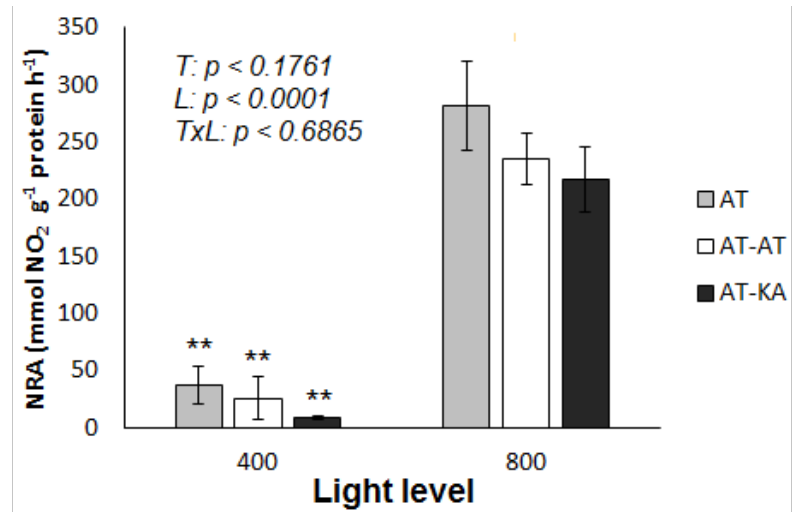
Figure 4. Nitrate Reductase Activity (NRA) in leaves from plants exposed to medium (400 µmol PAR m − 2 s − 1 ) or high (800 µmol PAR m − 2 s − 1 ) light level. Bars represent mean ± SE of four replicates. p-Values for treatment ( T ), light ( L ) and the interaction ( TxL ) effects are included. Asterisks